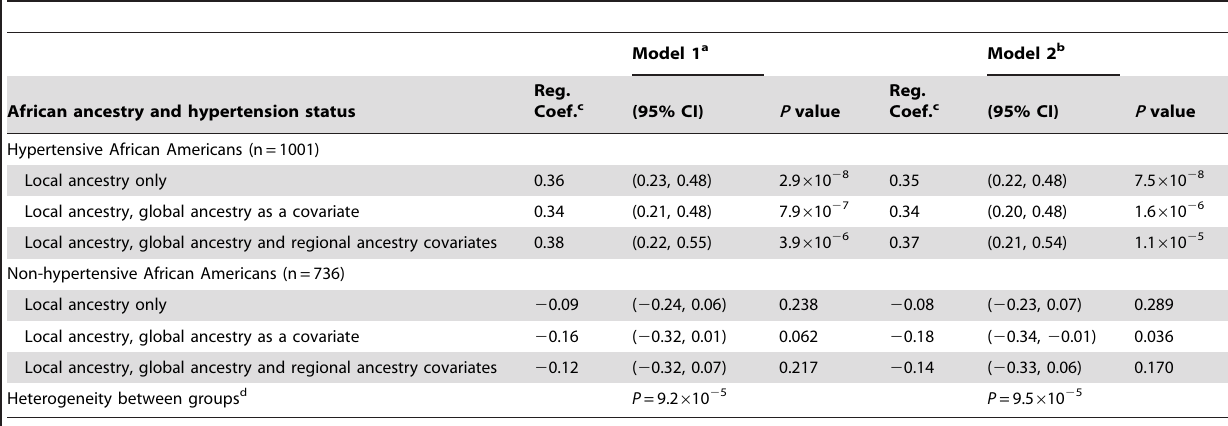
Table 3. Linear regression analysis of CRVE on local African ancestry on the chromosome 6 peak by hypertension